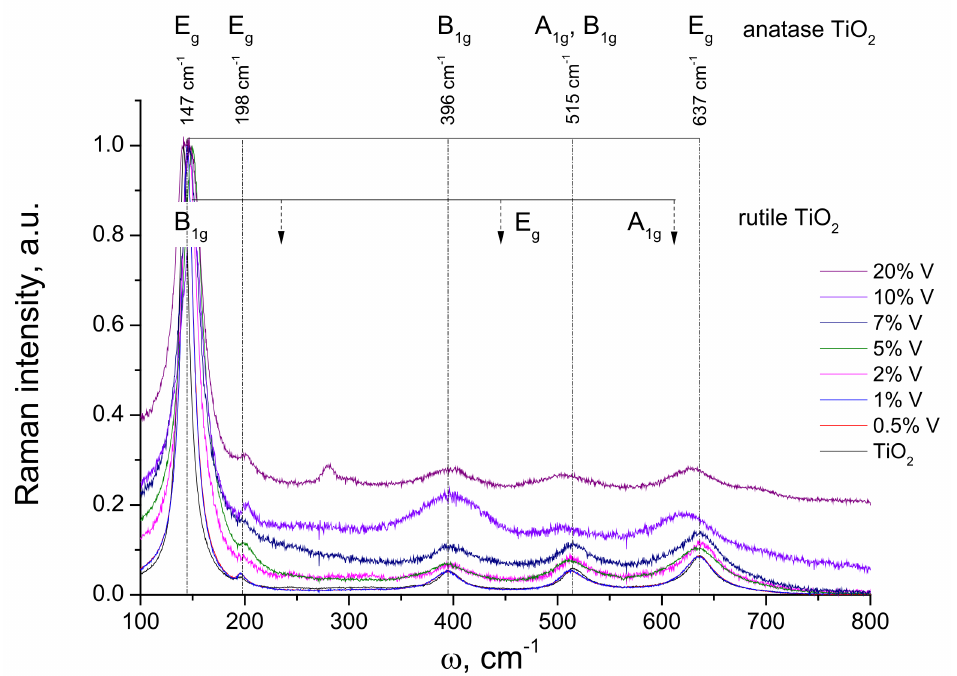
Figure 5. Raman spectra of V-TiO 2 samples calcinated at 450 ◦ C with different vanadium content. The positions of anatase and rutile TiO 2 bands are indicated by vertical dashed lines.